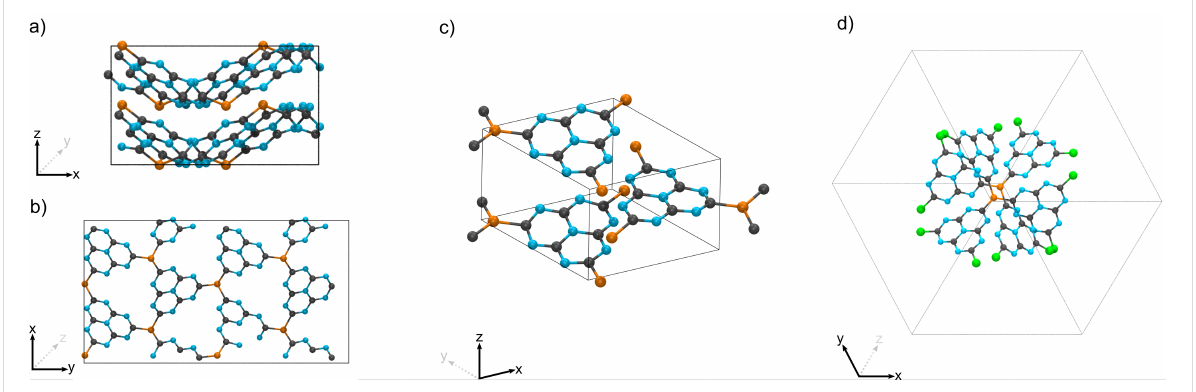
Figure 4: Calculated structures for a) corrugated (edge facing), b) corrugated (single layer), c) layered g-h-PCN and d) phosphine